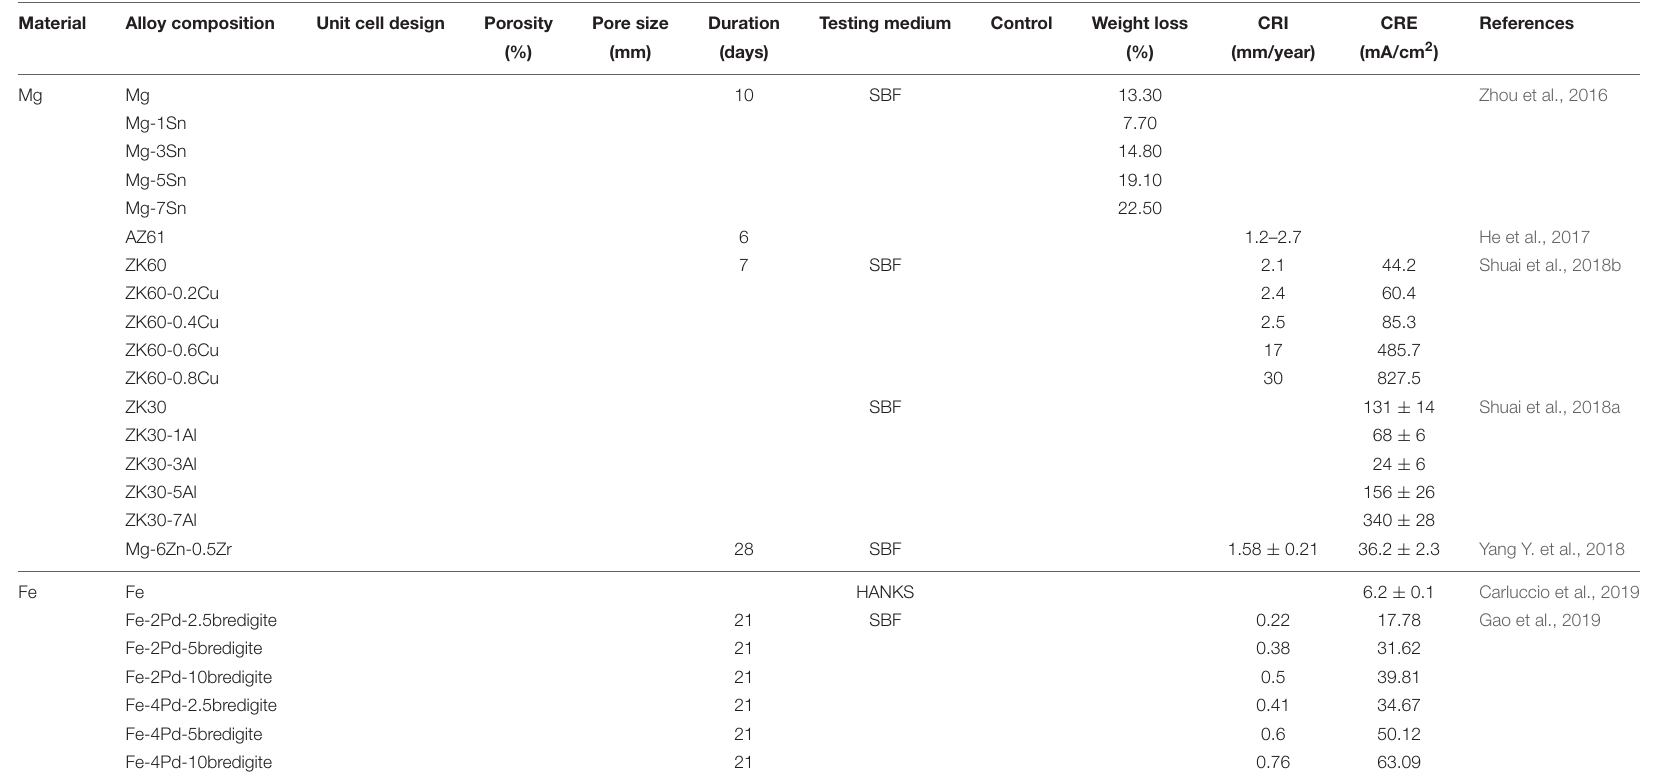
TABLE 1B | Corrosion behavior of selected solid and porous absorbable metals produced by SLM.